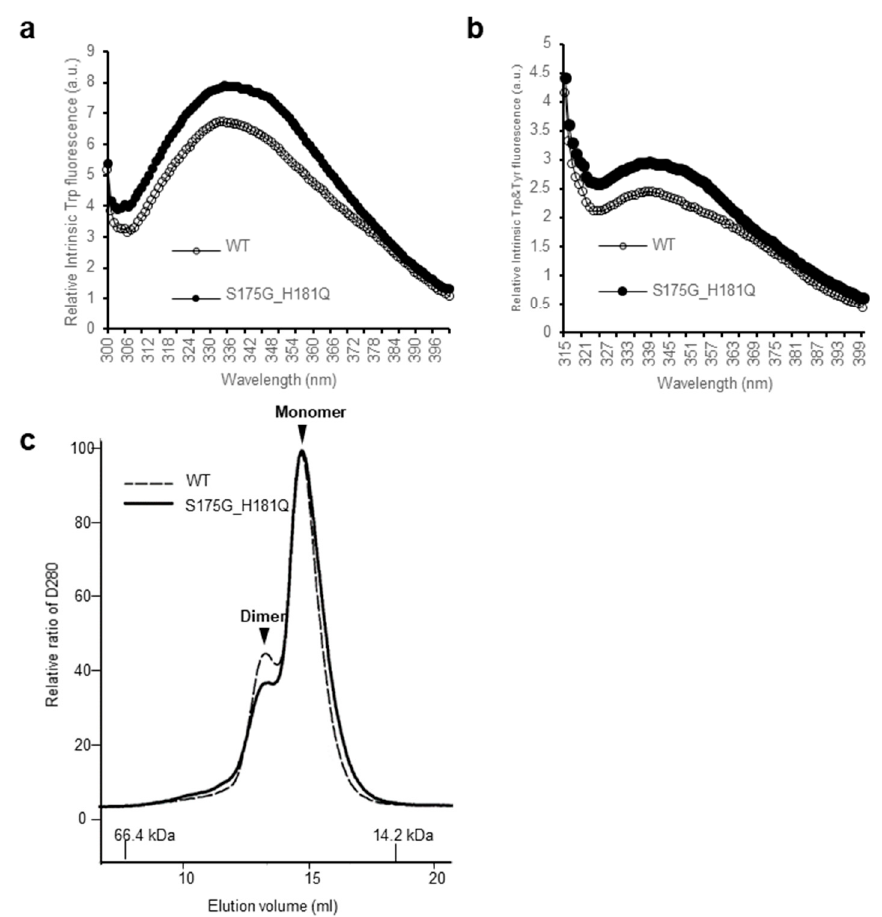
Figure 1. Effect of the double mutations (S175G/H181Q) on the secondary, tertiary structures and oligomerization of β B2-crystallin. ( a ) Intrinsic Trp fluorescence excited at 295 nm. ( b ) Intrinsic Trp and Tyr fluorescence excited at 280 nm. The proteins were prepared in PBS buffer with concentration of 0.5 mg/mL. The fluorescence intensity was recorded for every 1 nm for WT (opened circles) and the S175G/H181Q mutant (closed circles). ( c ) Size exclusion chromatograms of WT and S175G/H181Q mutant β B2-crystallin using Superdex TM 200 HR 10/30 column. 450 µg of WT protein (black dotted line) and the S175G/H181Q mutant (black line) were loaded on column equilibrated with PBS buffer. Albumin (66.4 kDa) and α -lactalbumin (14.2 kDa) were used as molecular weight markers.